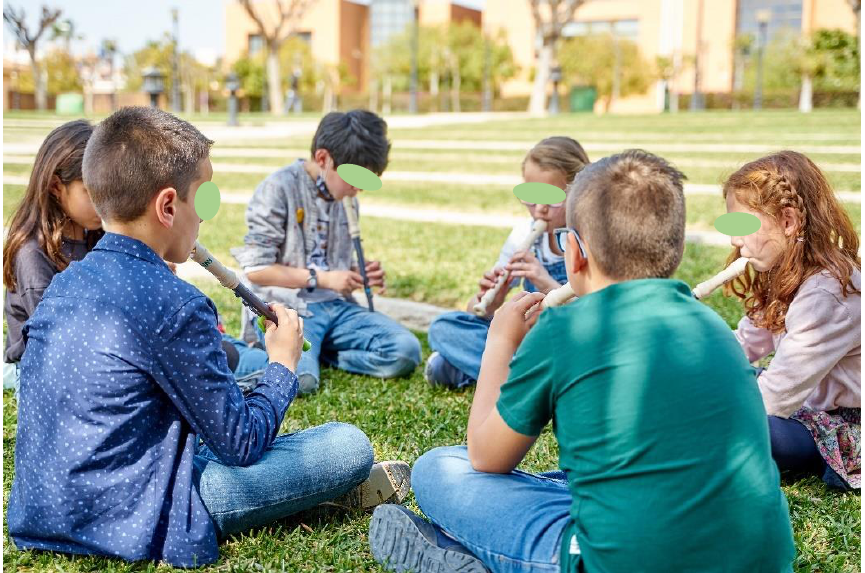
Figure 10. Inclusive school activity using Flow and other recorders.